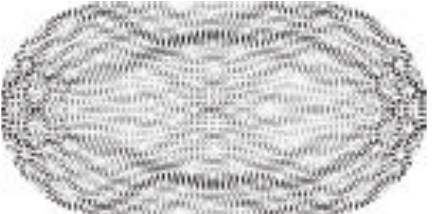
Figure 23: A contour plot of an electron density for Kd = 7, r/d = 10, and the fundamental mode